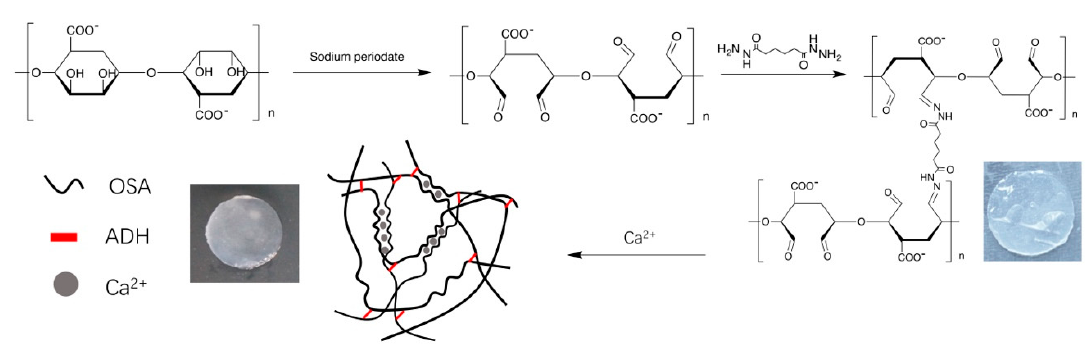
Figure 1. The schematic of fabricating adipic dihydrazide crosslinked oxidized sodium alginate (ADH-OSA) gel.